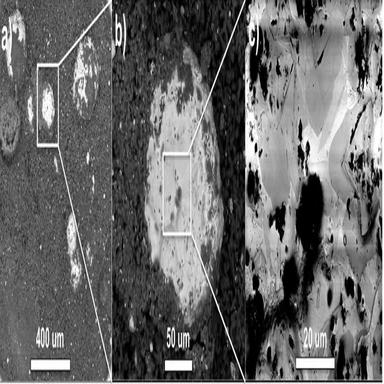
Large area elemental X-ray maps of the slag-like material on the metal product's surface. All scale bars are 500 μm. The white square in the SE image indicates the region magnified in